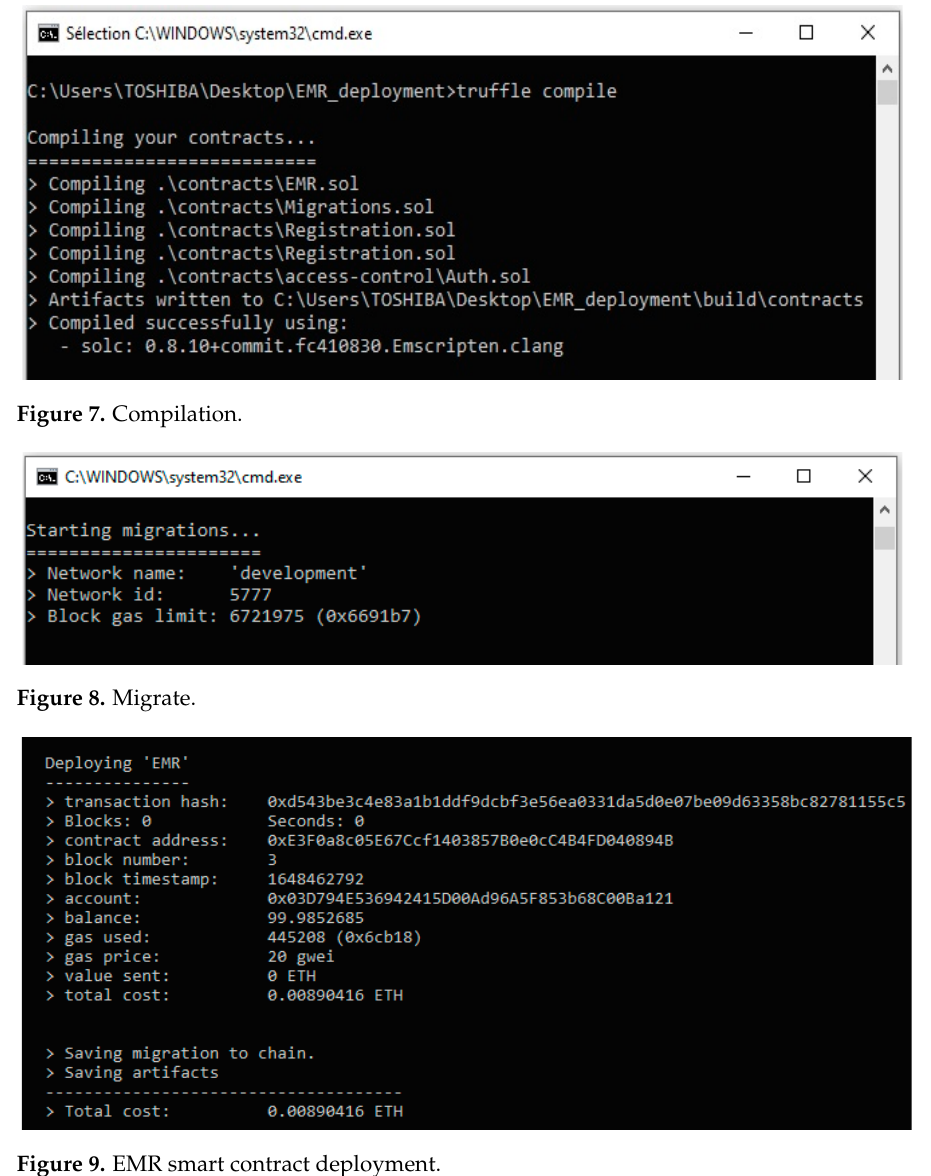
Figure 9. EMR smart contract deployment.